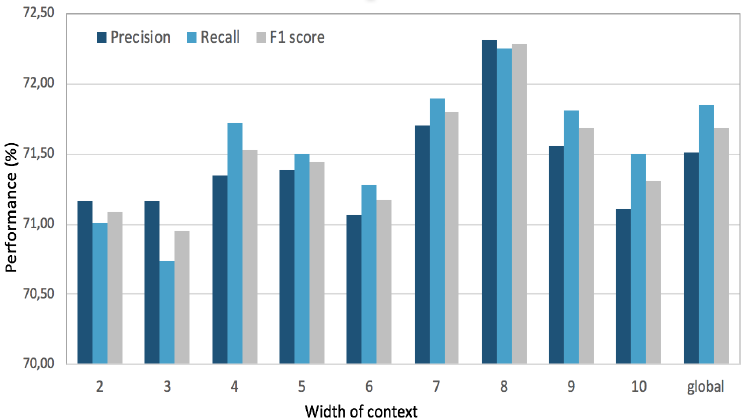
Figure 8. Performance of BiLSTM with respect to various sizes of context.